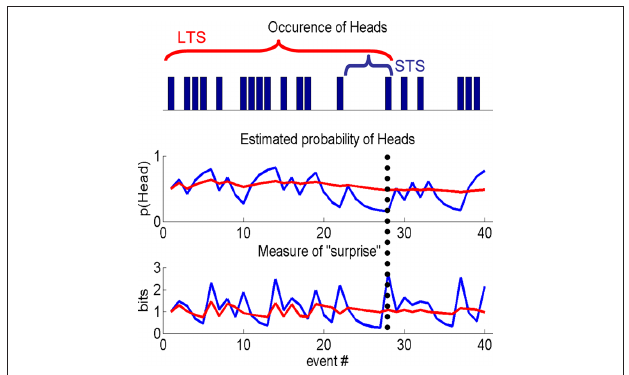
FIguRe 1 | Information theoretic indices. A sample from a Bernoulli process, e.g., a sequence of coin tosses, over 40 events (top panel), schematic showing differences in the estimated probability of Heads, given past samples (middle panel) and a typical IT measure, i.e., “surprise,” used in a computational model to quantify subject responses (lower panel). Short (STS) or long time scale (LTS), i.e., integration over few or many past events, are shown by the blue and red traces, respectively. The differences between the two processes are best appreciated by considering the 28th event (indicated by the vertical dotted line). The estimated probability of Heads is low for the STS as it is the first Head in five events. By contrast, many samples have occurred over a longer period, which is reflected in the estimate using the LTS. STS is therefore sensitive to local changes (over events) in the process, whereas the LTS averages these out. This is seen again when considering a function of the estimated probability of Heads, e.g., the negative log of this estimate, i.e., the surprise. For the STS the probability of Heads is low and therefore the surprise is high compared to the LTS that estimates the coin to be